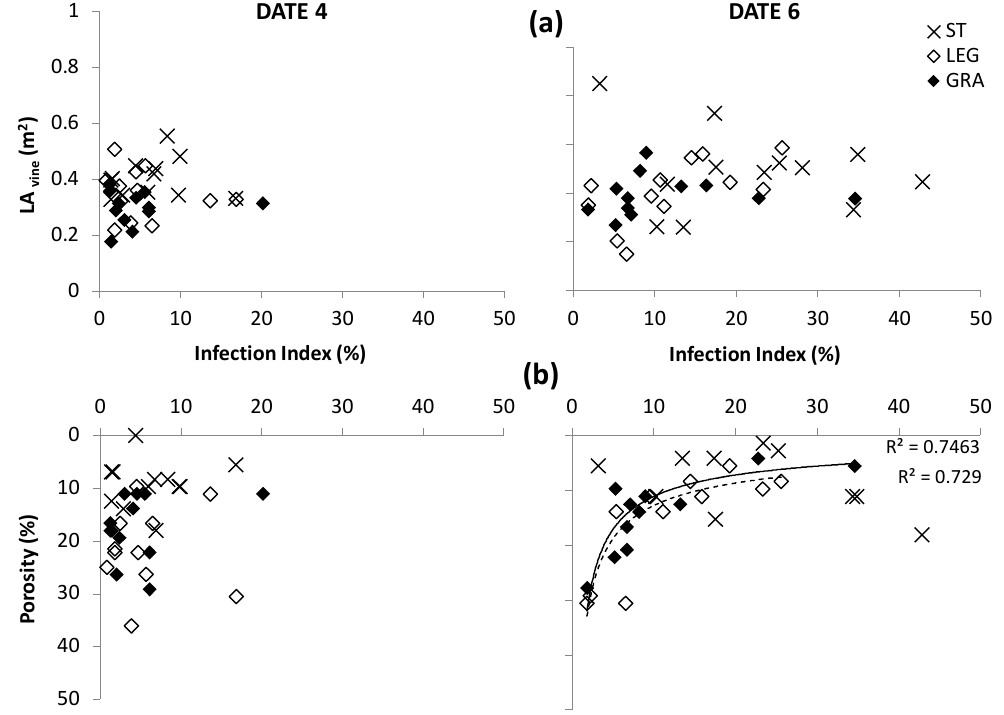
Figure 8. Relationship between the powdery mildew infection index and total LA per vine ( a ) and canopy porosity ( b ) during disease observation dates 4 and 6 in the canopy wall, for the three ‐ season study period.